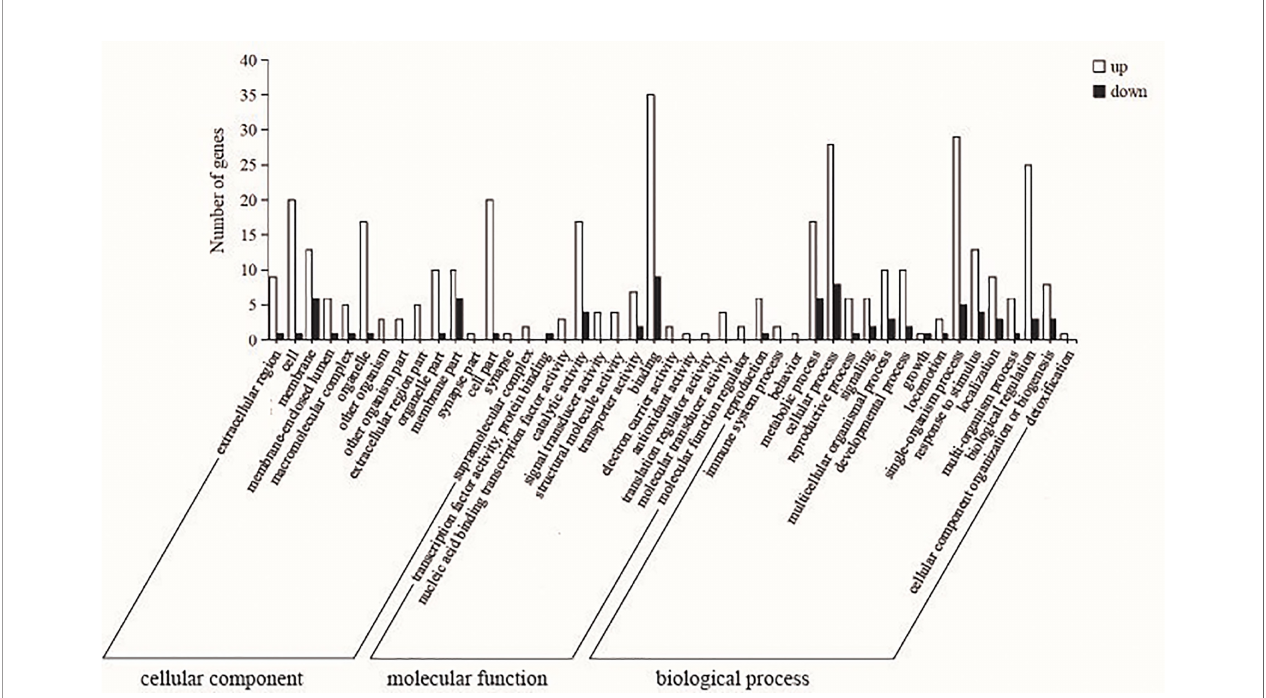
FIGURE 5 | Enrichment analysis of liver differentially expressed genes (DEGs) gene ontology (GO) between control and sbGnRH injection groups. White bars indicate up-regulated genes; Black bars indicate down-regulated genes; the Y-coordinate represents the number of genes; the X-coordinate represents the name of the